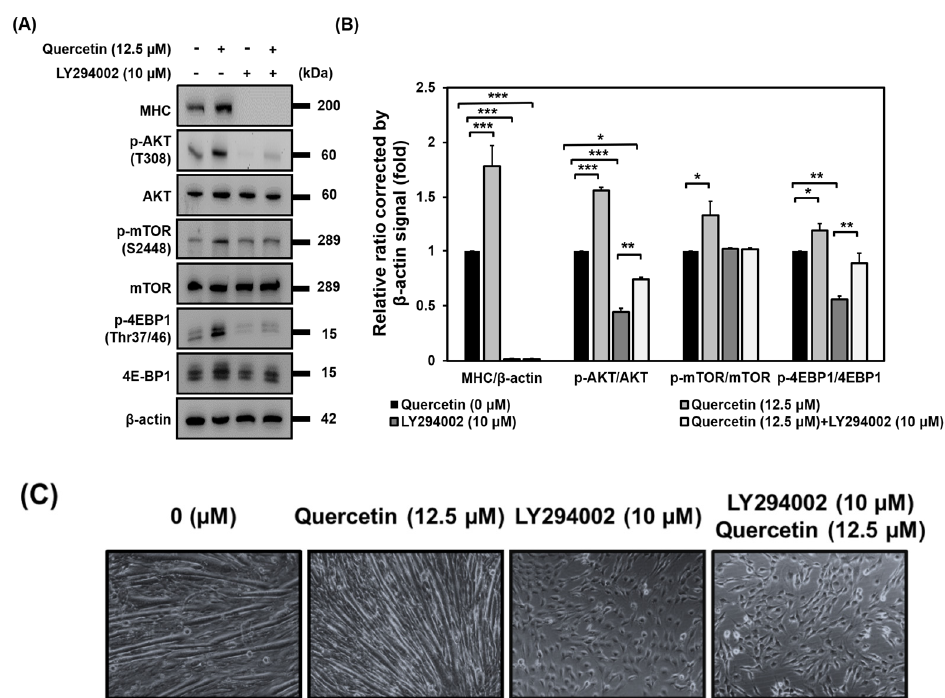
Figure 8. AKT activation was required for quercetin to induce myogenic differentiation. C2C12 cells were grown to 80% confluency density in a 24 − well plate. The cells were pre-treated with or without LY294002 (10 μ M) for 30 min. They were then untreated or treated with quercetin 0, 12.5 μ M and cultured in DMEM medium containing 2% horse serum to promote cell differentiation for 7 days. ( A ) Western blot analysis was used to study the effect of quercetin on the expression of proteins related to AKT signaling, with β -actin used as internal control. ( B ) Bar graph shows the relative expression of the unphosphorylated and phosphorylated proteins. ( C ) Microscopic images of C2C12 cells represent myotube formation after 7 days. Data are expressed as mean ± SD based on three independent biological repeats ( n = 3). There were significant differences between the controls and the quercetin-treated, LY294002-treated, and LY294002- and quercetin-treated groups, * p < 0.05, ** p < 0.01, and *** p < 0.001, respectively.